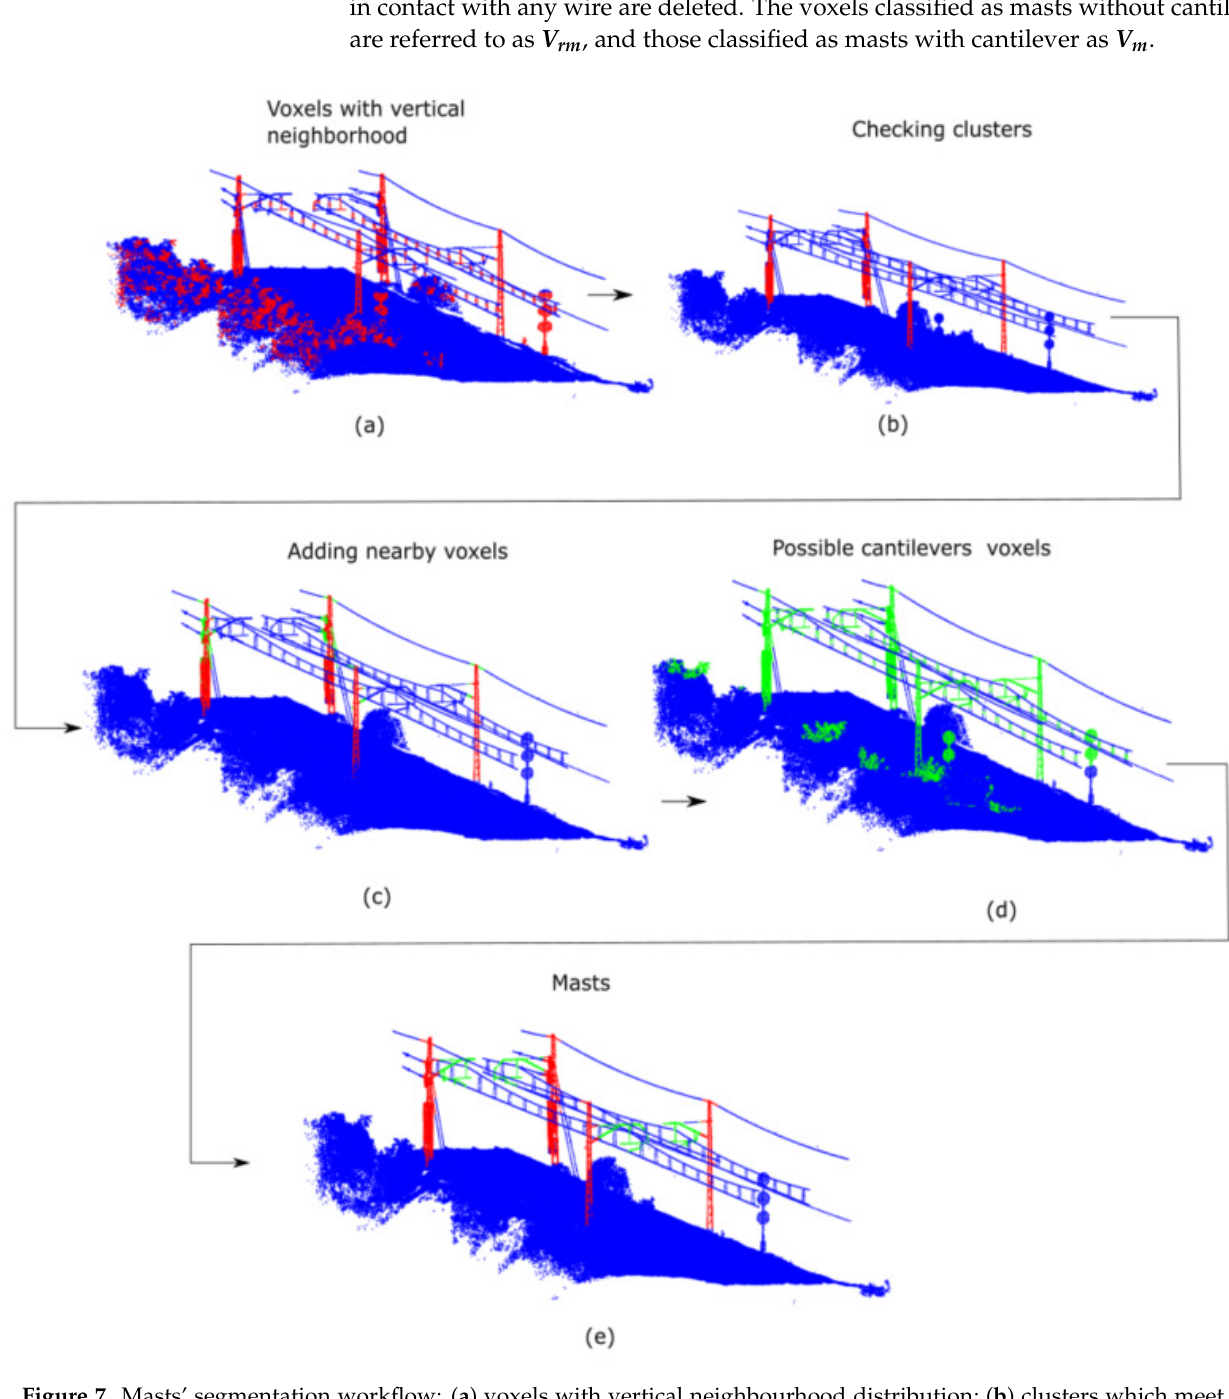
Figure 7. Masts’ segmentation workflow: ( a ) voxels with vertical neighbourhood distribution; ( b ) clusters which meet the “Mast without cantilever” model specifications; ( c ) previous clusters, coloured in red, and the new voxels added to each mast, coloured in green; ( d ) possible cantilever’s voxels, i.e., voxels whose neighbourhood has no dispersion in the trajectory direction; ( e ) masts without cantilever, coloured in red, and cantilevers, coloured in